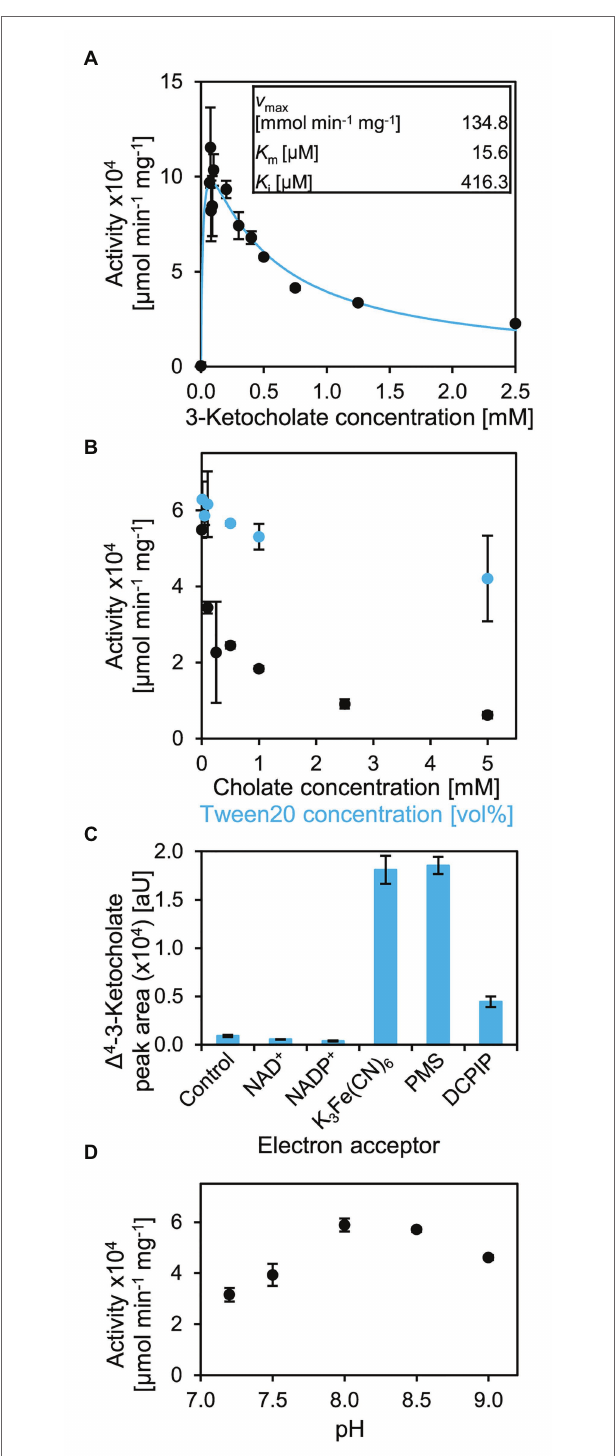
FIGURE 6 | Catalytic properties of 5 β - Δ 4 -KSTD1. (A) Kinetics of 5 β - Δ 4 - KSTD1. Activity with varying concentrations of 3-ketocholate ( 5 in Figure 2 ) and 1 mM K 3 Fe(CN) 6 at pH 7.8 (black) and modeling of kinetics for substrate inhibition with the given constants (blue). (B) Inhibitory effects of detergents cholate (black) and Tween20 (blue) on enzyme activity of 5 β - Δ 4 -KSTD1 with